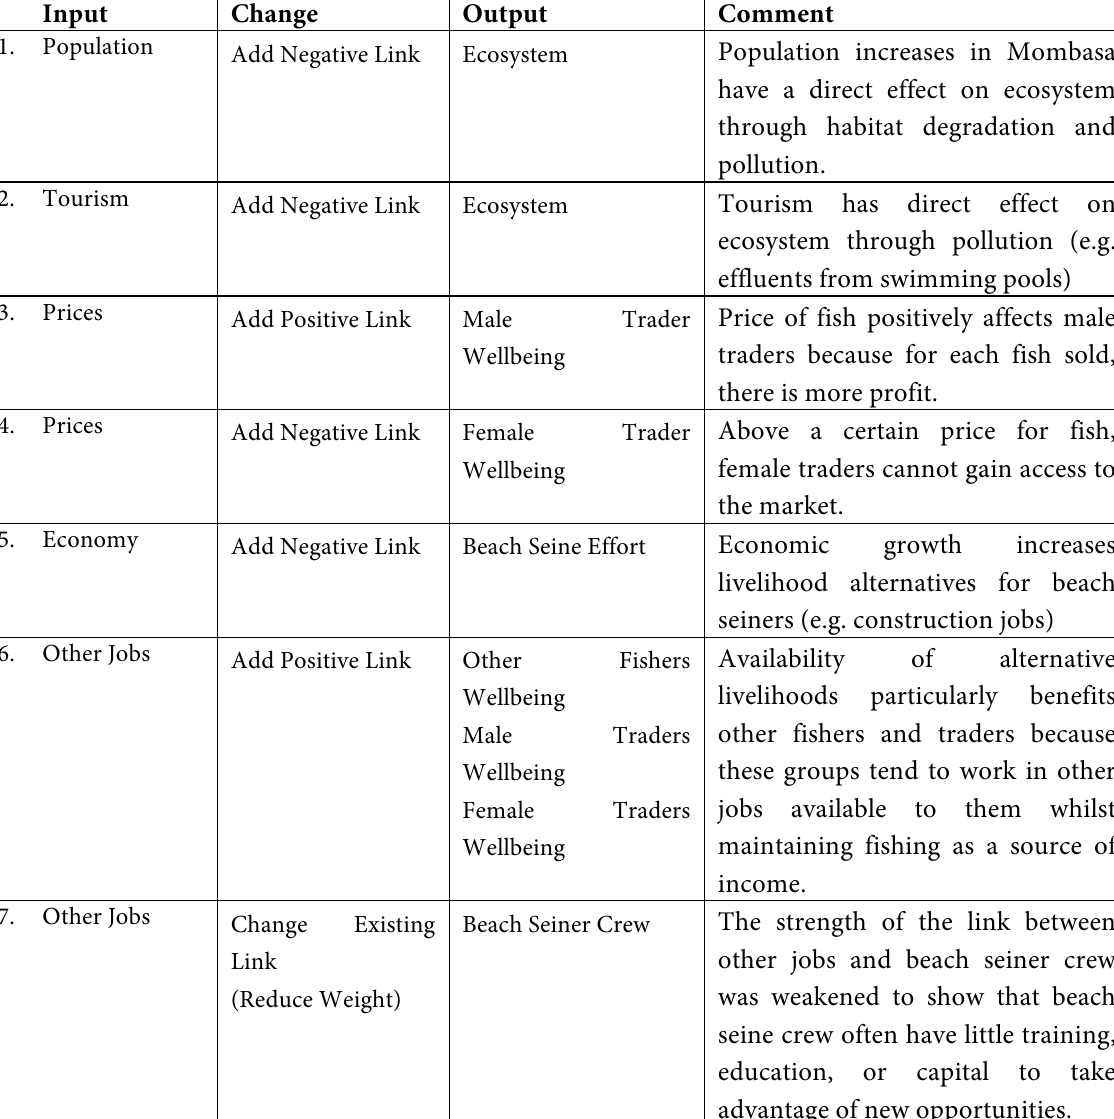
Table S3. Model revisions during workshop 2. Adapted from Supplementary material of Daw. et al.